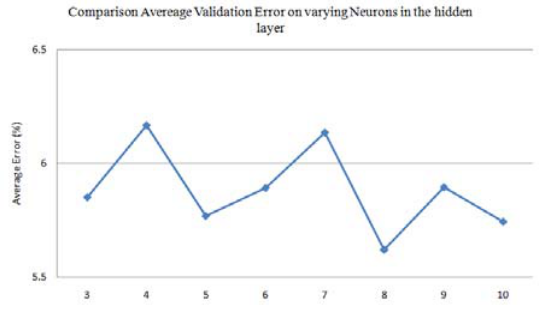
Fig. 3. Average error for combining Trails 1, 2, and